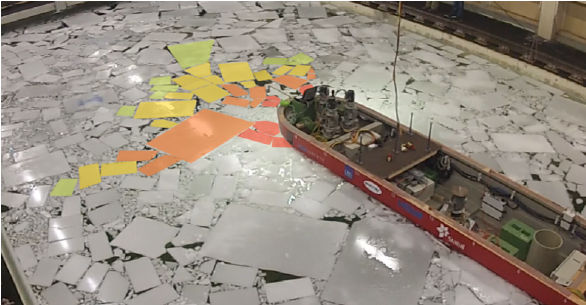
Figure 28: Examples of contact networks forming in the DP experiments at the HSVA